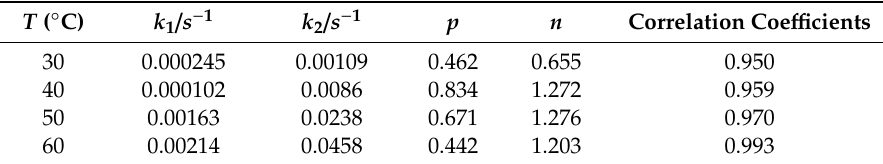
Table 1. The fitting model parameter